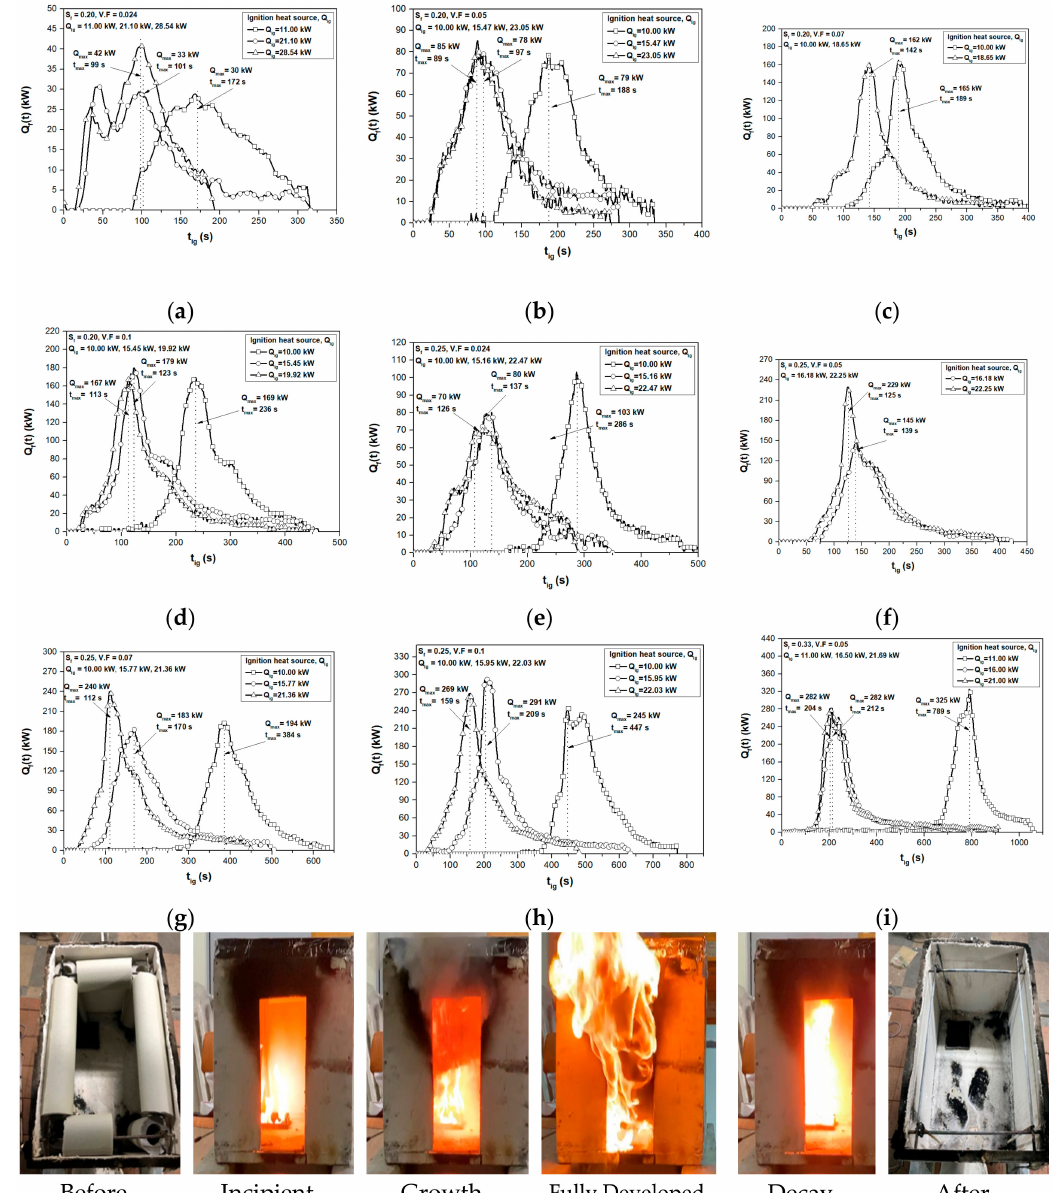
Figure 6. Experiment results of the heat release rate vs. ignition heat source for 0.33, 0.25, and 0.2 of the scale factor with a volume fraction of 0.024, 0.05, 0.07, and 0.1. ( a ) Test#1–Test#3. Heat release rate vs. time ( S f = 0.2, VF = 0.024, Q ig = 11.00 kW, 21.10 kW, 28.54 kW); ( b ) Test#4–Test#6. Heat release rate vs. time ( S f = 0.2, VF = 0.05, Q ig = 10.00 kW, 15.47 kW, 23.05 kW); ( c ) Test#7, Test#9. Heat release rate vs. time ( S f = 0.2, VF = 0.07, Q ig = 10.00 kW, 18.65 kW); ( d ) Test#10–Test#12. Heat release rate vs. time ( S f = 0.2, VF = 0.1, Q ig = 10.00 kW, 15.45 kW, 19.92 kW); ( e ) Test#13–Test#15. Heat release rate vs. time ( S f = 0.25, VF = 0.024, Q ig = 10.00 kW, 15.16 kW, 22.47 kW); ( f ) Test#17–Test#18. Heat release rate vs. time ( S f = 0.25, VF = 0.05, Q ig = 16.18 kW, 22.25 kW); ( g ) Test#19–Test#21. Heat release rate vs. time ( S f = 0.25, VF = 0.07, Q ig = 10.00 kW, 15.77 kW, 21.36 kW); ( h ) Test#22–Test#24. Heat release rate vs. time ( S f = 0.25, VF = 0.1, Q ig = 10.00 kW, 15.95 kW, 22.03 kW); and ( i ) Test#28–Test#30. Heat release rate vs. time ( S f = 0.33, VF = 0.05, Q ig = 11.00 kW, 16.50 kW, 21.69